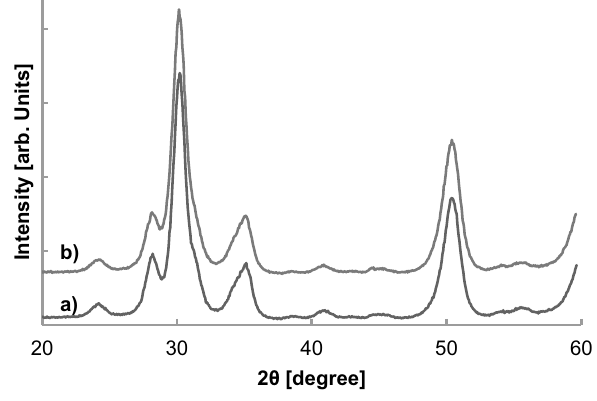
Fig. 3 XRD patterns of powders calcined at 450 °C; (a) lCsZrO hCsZrO